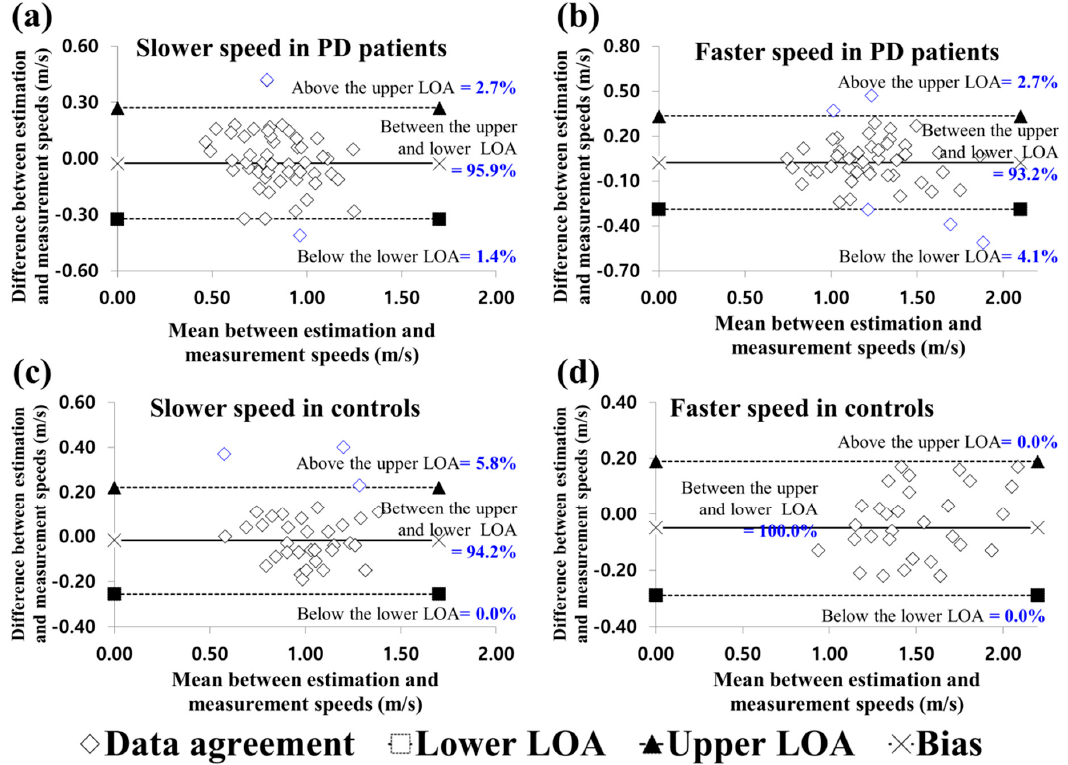
Figure 3. Bland-Altman plots for data agreement between the estimated and measured overground